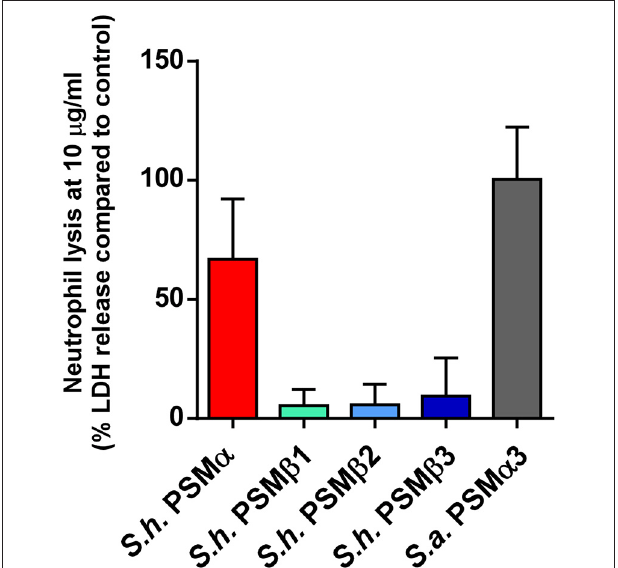
FIGURE 7 | Cytolytic activities of S. haemolyticus PSMs toward human neutrophils. Cytolytic activities of S. haemolyticus PSMs and S. aureus PSM α 3 at 10 µ g/ml were measured using incubation with human neutrophils by release of lactate dehydrogenase (LDH). Activities are compared as percentage compared to a control with total lysis. Triplicate measurements were performed each using neutrophils obtained from three